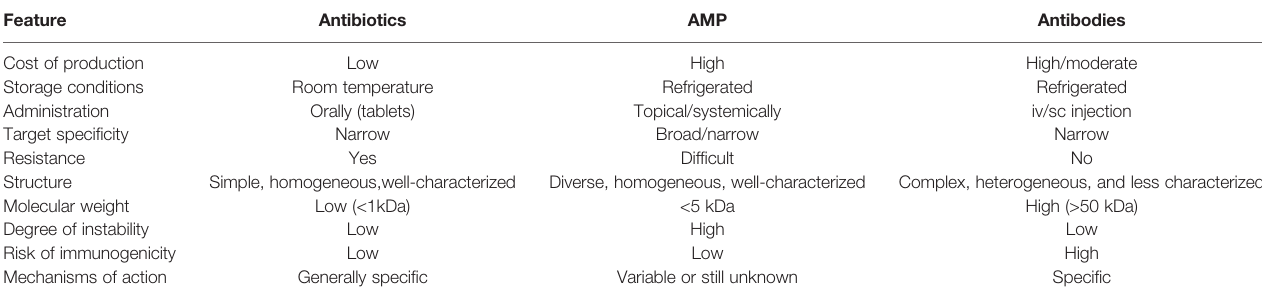
TABLE 1 | Different features of antibiotics, antibodies, and antimicrobial peptides as anti-infective agents for infectious diseases.